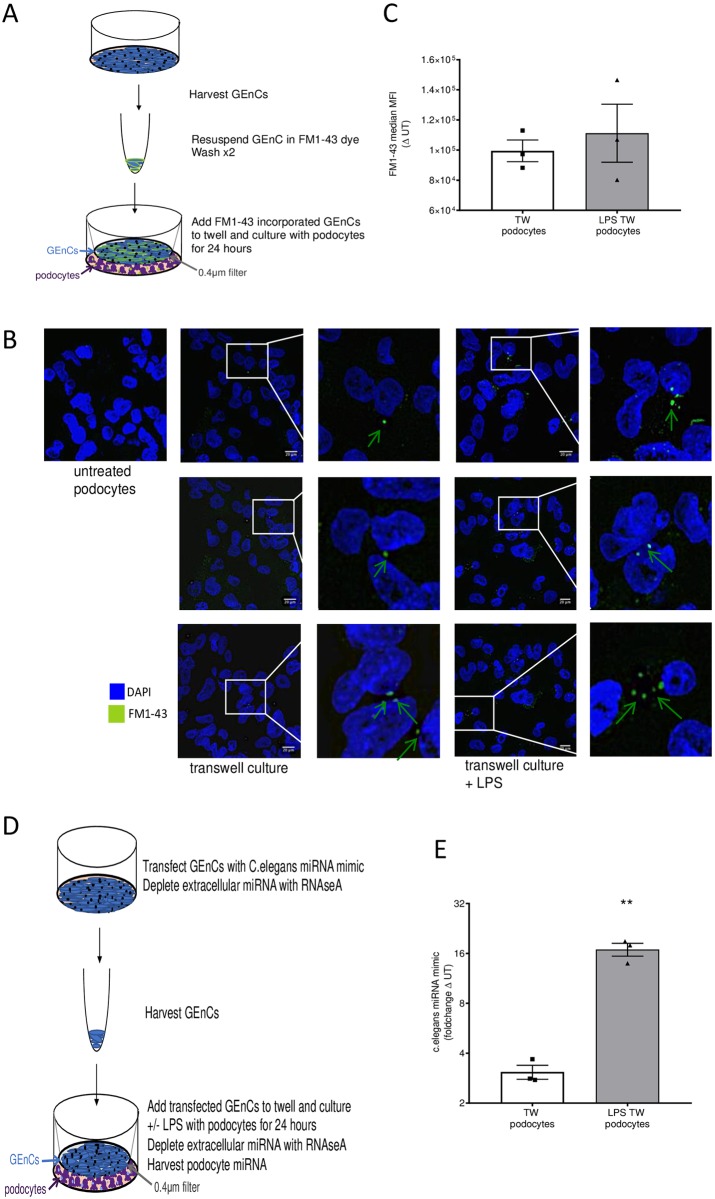
Podocyte incorporation of GEnC derived EV.A) Illustration of the transwell culture of GEnC and podocytes, allowing non-contact transfer of EV. Cells are cultured in exosome free FBS. B) Representative images of podocyte EV uptake post 24-hour culture with GEnC derived EV. Podocytes remained untreated or cultured with EV from GEnC exposed to FM1-43X, with or without LPS activation. GEnC were washed prior to seeding onto transwell filters, to remove any unbound dye. Confocal images were acquired on a Leica SP5 confocal microscope. Scale bar represents 10μm. Arrows indicated FM1-43X positive GEnC EV (green). Blue = podocyte nuclei C) Median fluorescence intensity in TW (transwell) treated podocytes with EV from steady state GEnC or LPS activated GEnC. Fluorescence was measured by flow cytometry. Backdrop suppressor was added to podocytes to remove any extracellular dye/signal. n = 3 D) Illustration of GEnC transfected with a C. elegans miRNA mimic using lipofectamine. GEnC were cultured (top) on to a 0.4μm transwell filter and cultured with podocytes (bottom) for 24 hours. RNAseA was added to the podocytes to remove any free extracellular RNA, prior to podocyte RNA isolation. E) Fold change (from untreated non transfected GEnC–UT) in C. elegans miRNA in TW (transwell) treated podocytes with EV from steady state GEnC or LPS activated GEnC. n = 4 ** represents P<0.01.